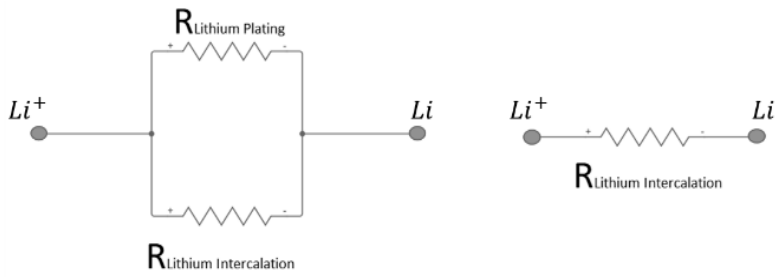
Figure 5. Electrical analogy representing the competition of Lithium plating with the intercalation phenomenon.